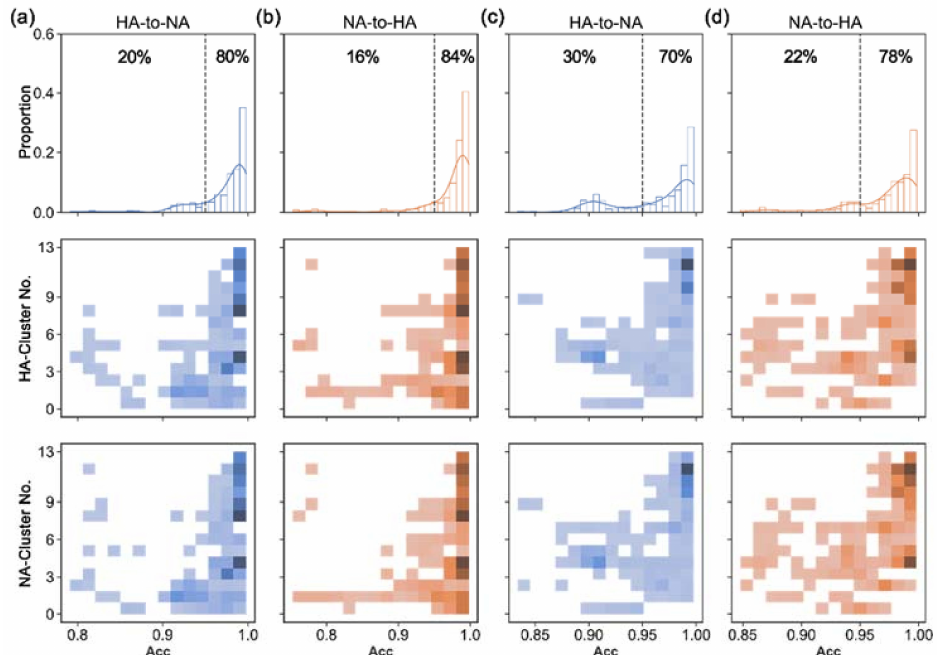
Figure 5. Distribution of translation accuracies using selected strains in the testing dataset. ( a ) A/H1N1, from HA to NA (“HA-to-NA”); ( b ) A/H1N1, from NA to HA (“NA-to-HA”); ( c ) A/H3N2, from HA to NA; ( d ) A/H3N2, from NA to HA. The X-axis represents the transla- tion accuracies; Y-axis respectively indicates the proportion of accuracies, HA-cluster number, and NA-cluster number, from top to bottom. The proportions of strains with translation accuracies greater than 0.95 (or less than 0.95) are indicated in the first line of images. The accuracy distribution of each HA and NA cluster is counted in the second and the third lines of images: the darker the color, the more strains there will